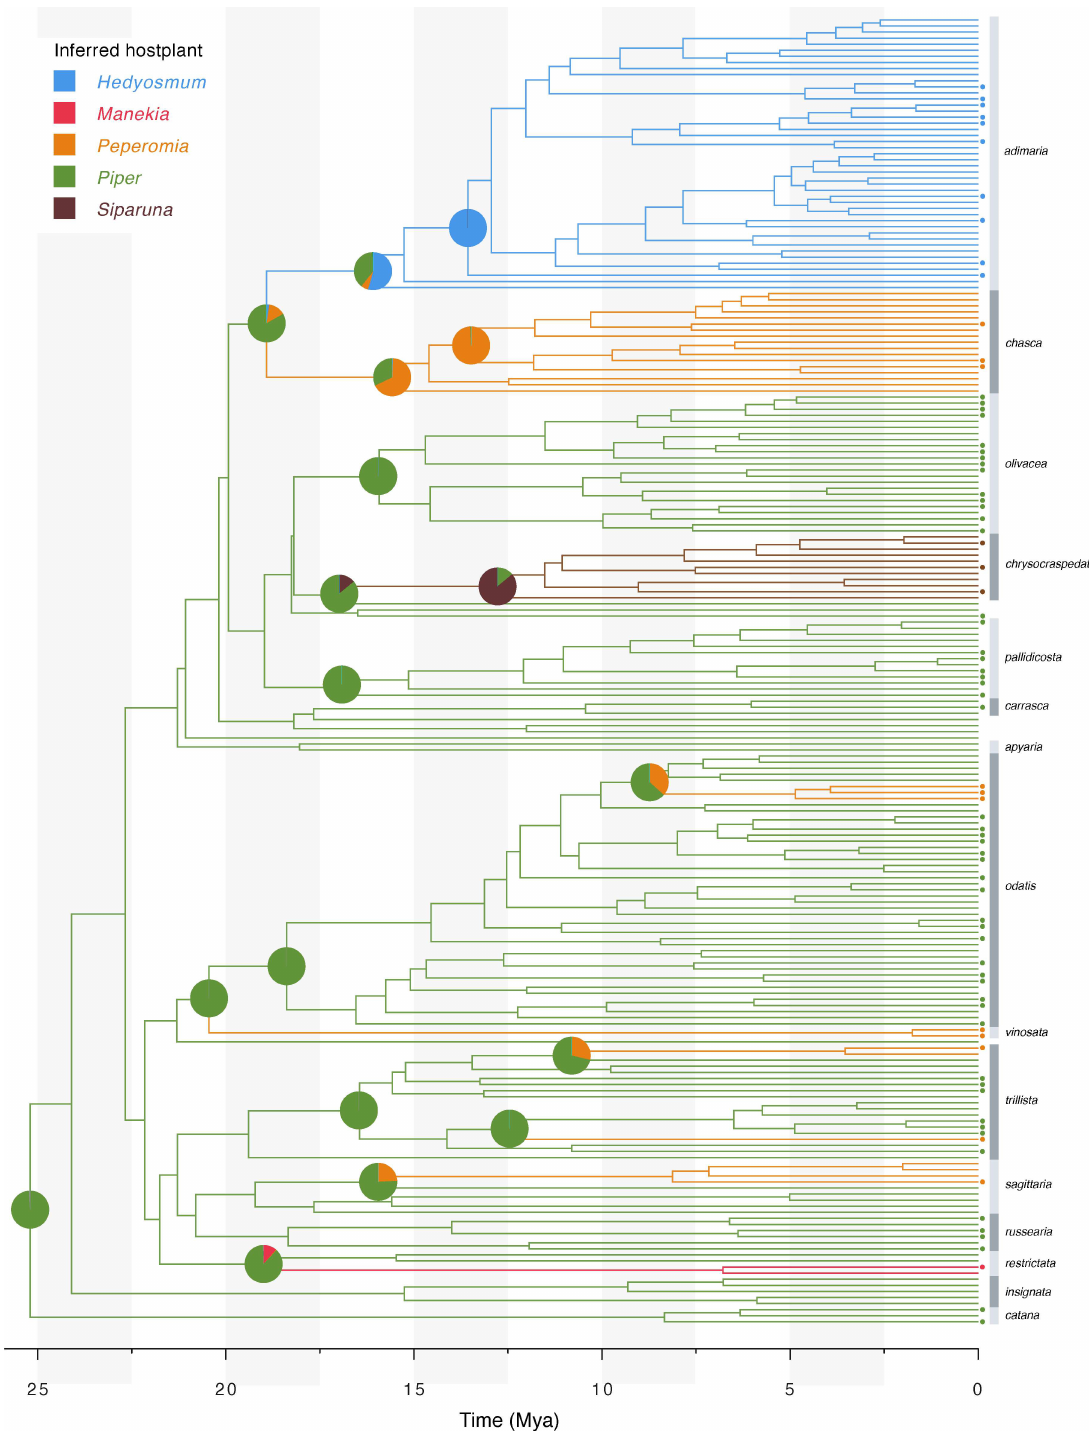
Fig 5. Reconstruction of ancestral host plant use. Branches are colored according to the most likely state, pie charts displaying the probability of all states were plotted at nodes where shifts in host plant use occurred. Dots next to tips indicate the presence of a host plant record for this particular